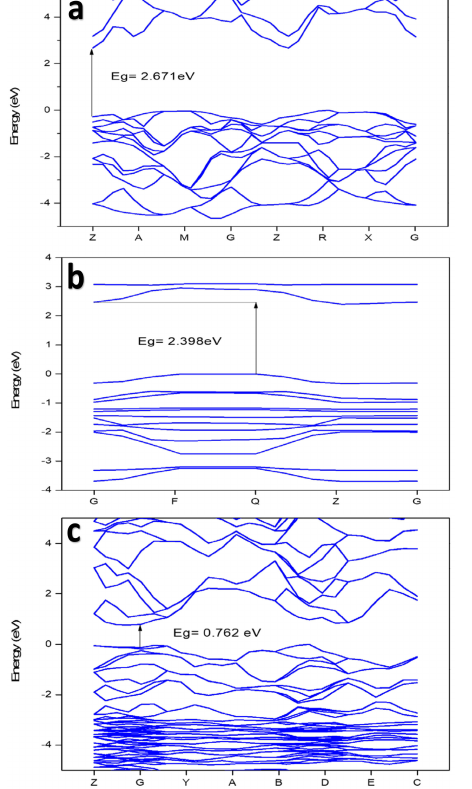
Figure 3. Calculated band structure of: ( a ) BiOCl, ( b ) BiOCl/Ag 2 S, and ( c ) BiOCl/Bi 2 O 3